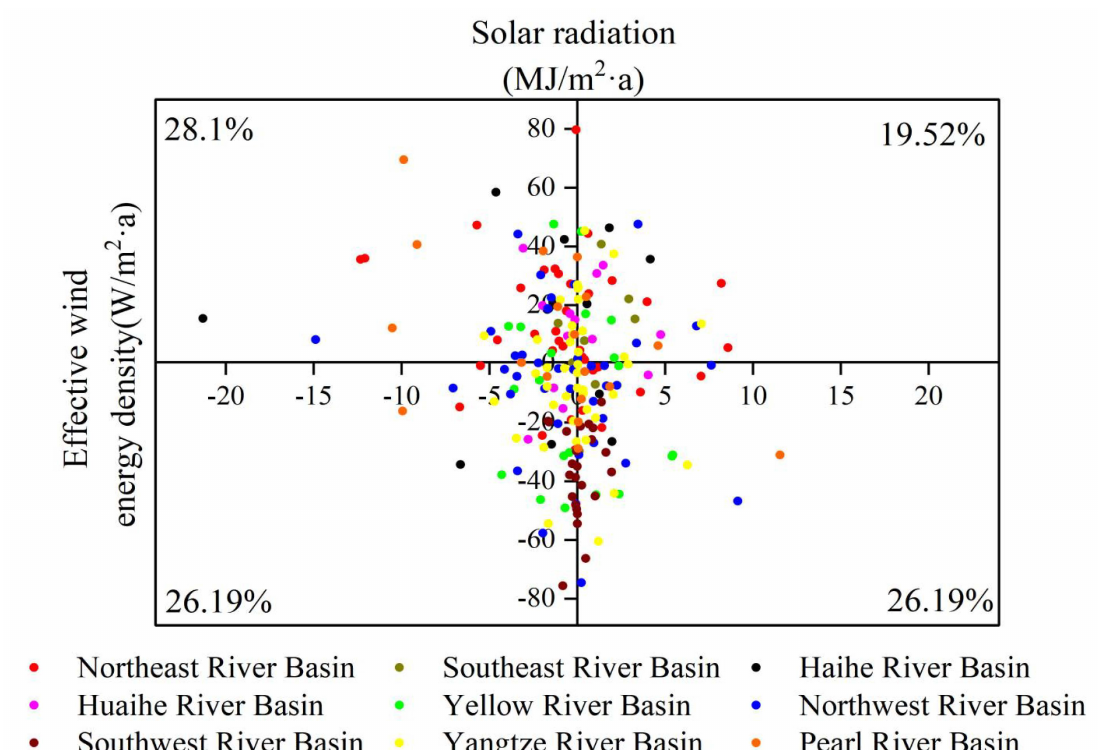
Figure 7. Interannual trends of wind and solar energy at each meteorological site in a watershed in